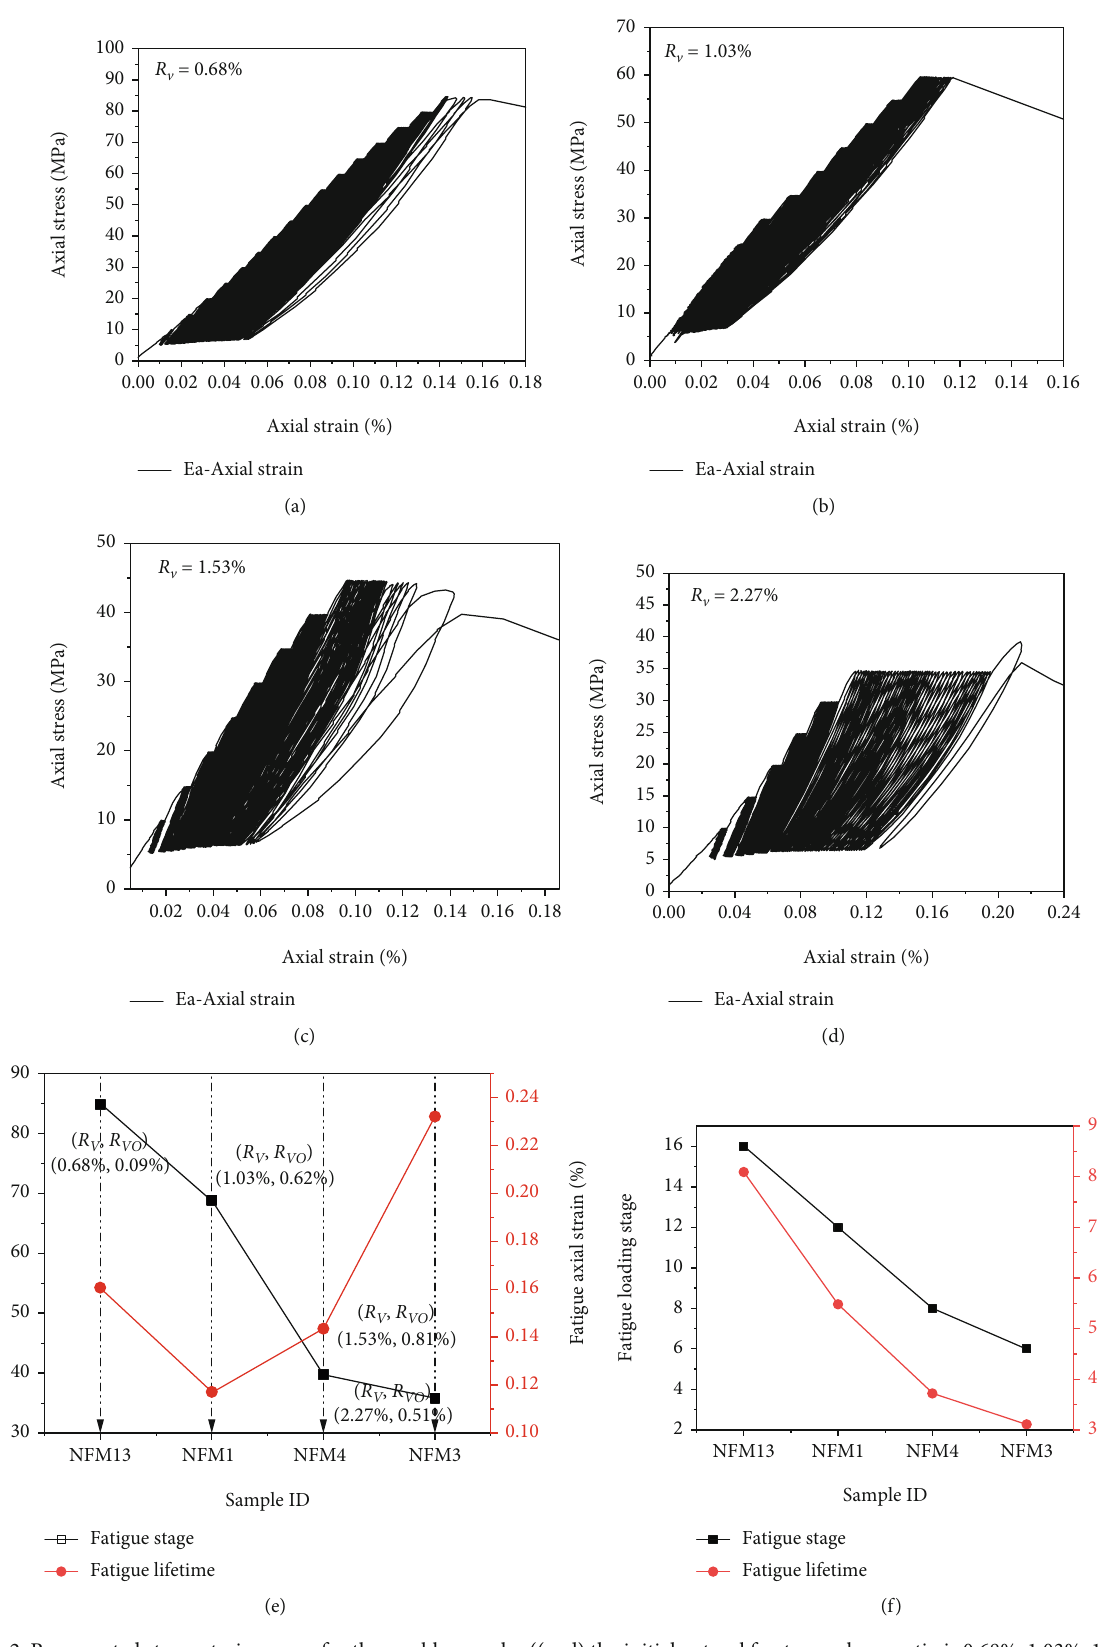
Figure 2: Represented stress-strain curves for the marble samples ((a – d) the initial natural fracture volume ratio is 0.68%, 1.03%, 1.53%, and 2.27%,